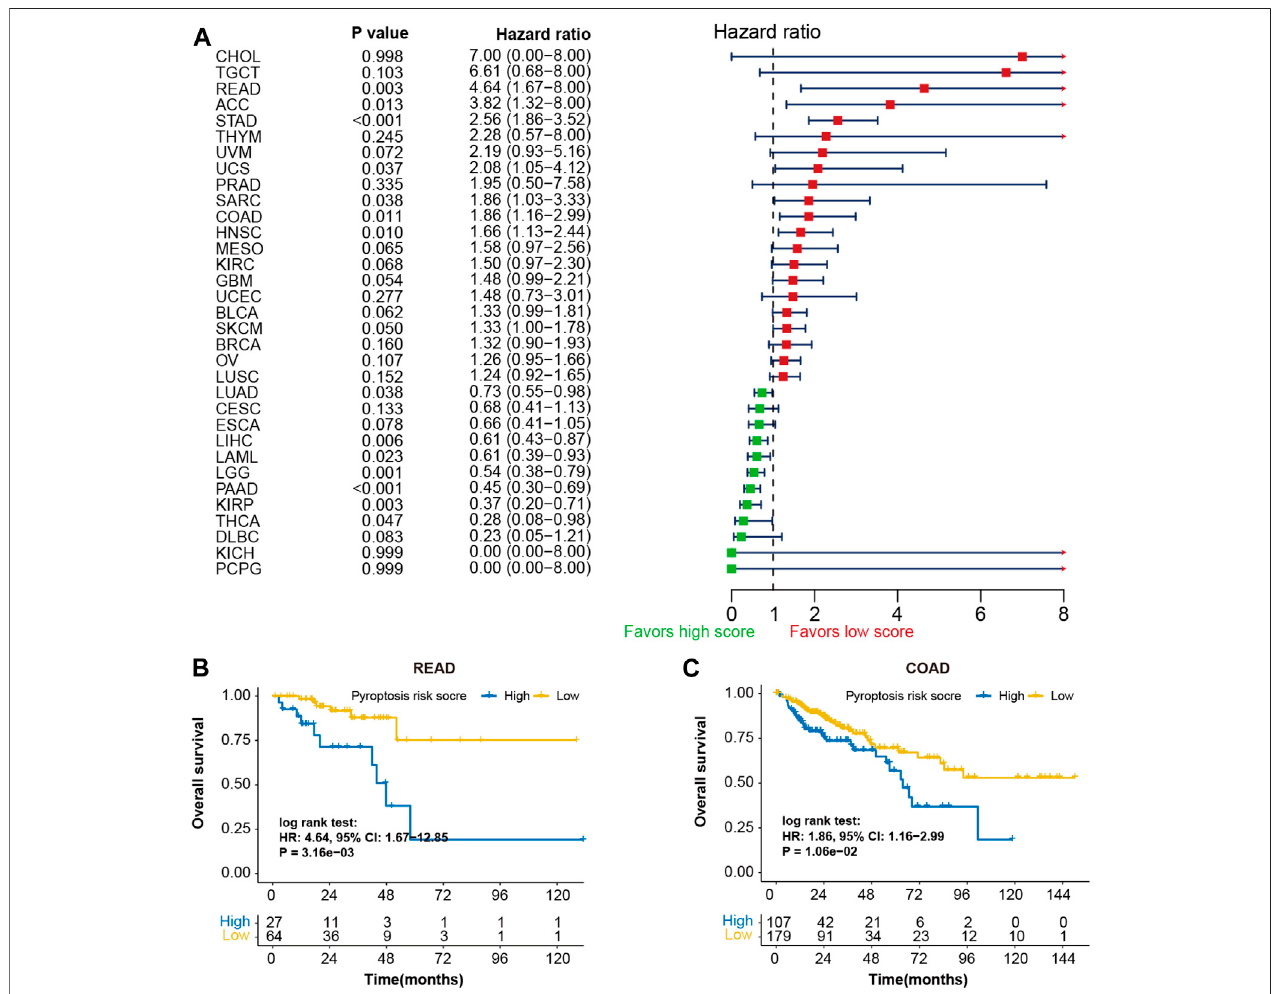
FIGURE 6| Prognostic values of pyroptosis risk score in 33 cancer types. (A) Forest plot depicting the hazard ratios for pyroptosis risk score in 33 cancer types of the TCGA cohorts. Kaplan-Meier curves of overall survival of patients with low- or high-pyroptosis risk score in rectum adenocarcinoma (B) and colon adenocarcinoma (C)